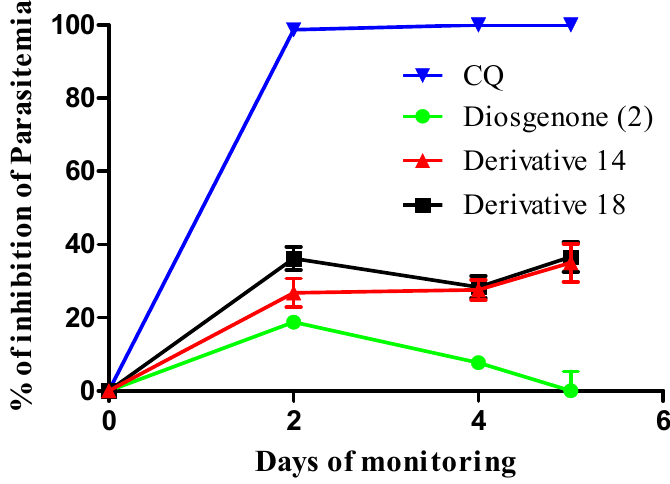
Figure 2. Percentage parasitemia inhibition in P. berghei -infected mice following treatment with derivatives 14 and 18